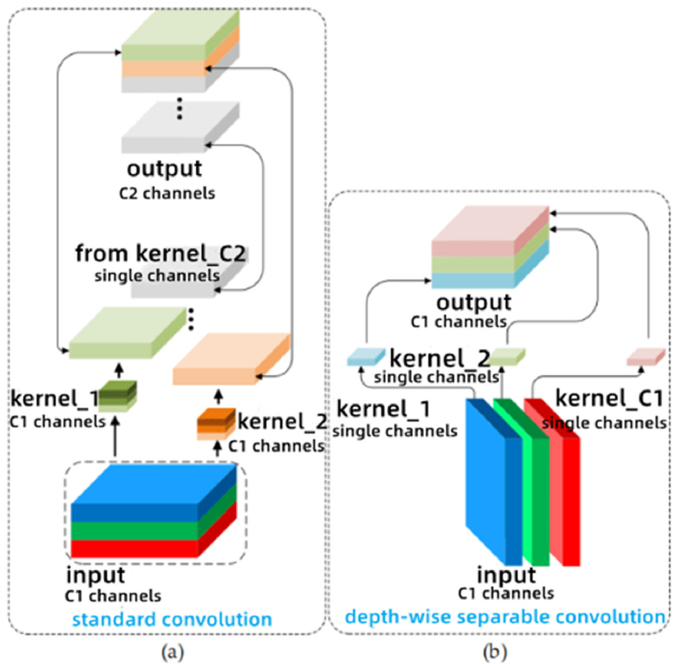
Figure 8. ( a ) Calculation process of SC; ( b ) Calculation process of DSC.